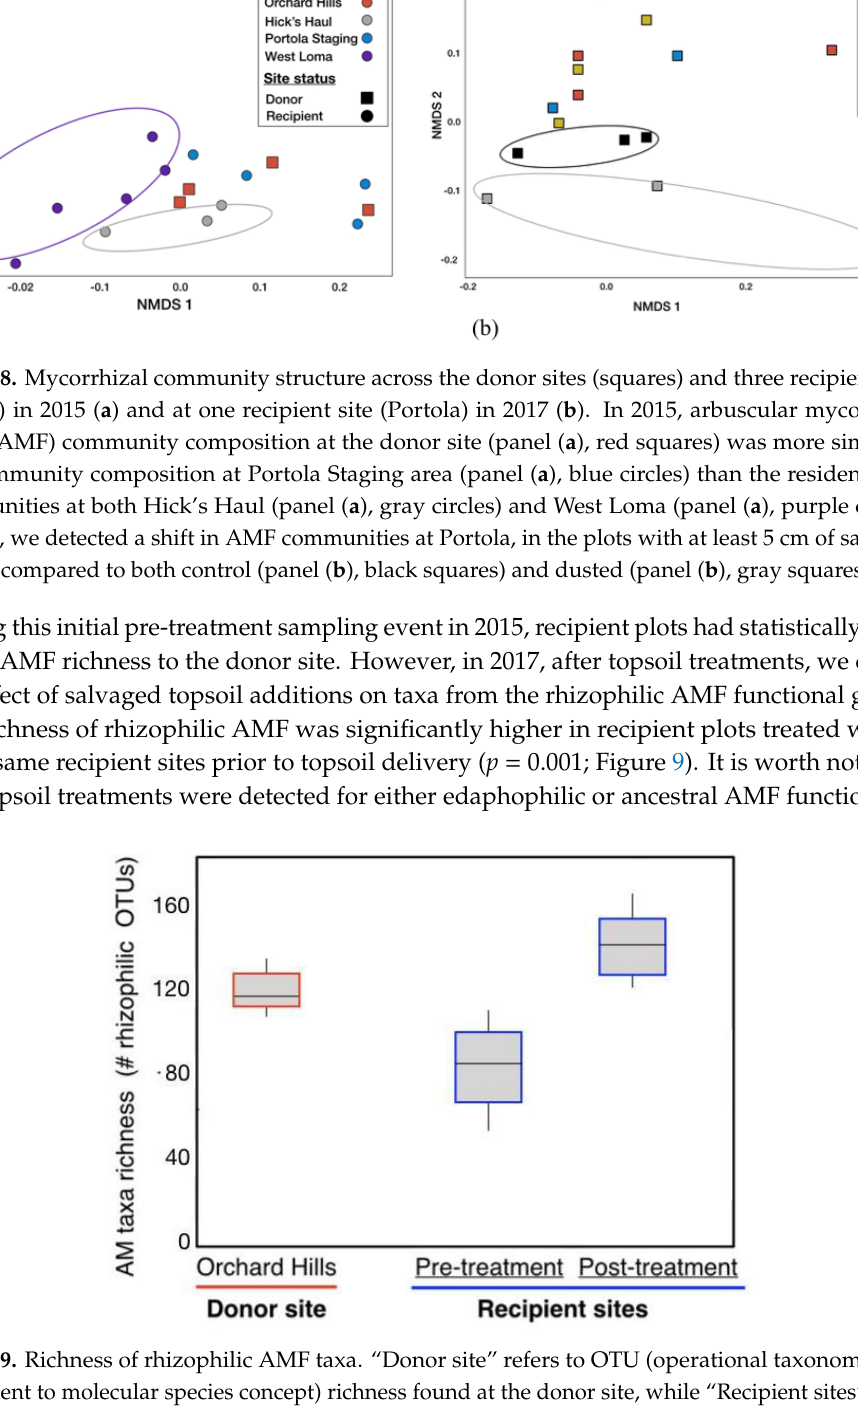
Figure 9. Richness of rhizophilic AMF taxa. “Donor site” refers to OTU (operational taxonomic unit, equivalent to molecular species concept) richness found at the donor site, while “Recipient sites” refers to all other sampling locations at the recipient sites. Rhizophilic AMF richness was measured